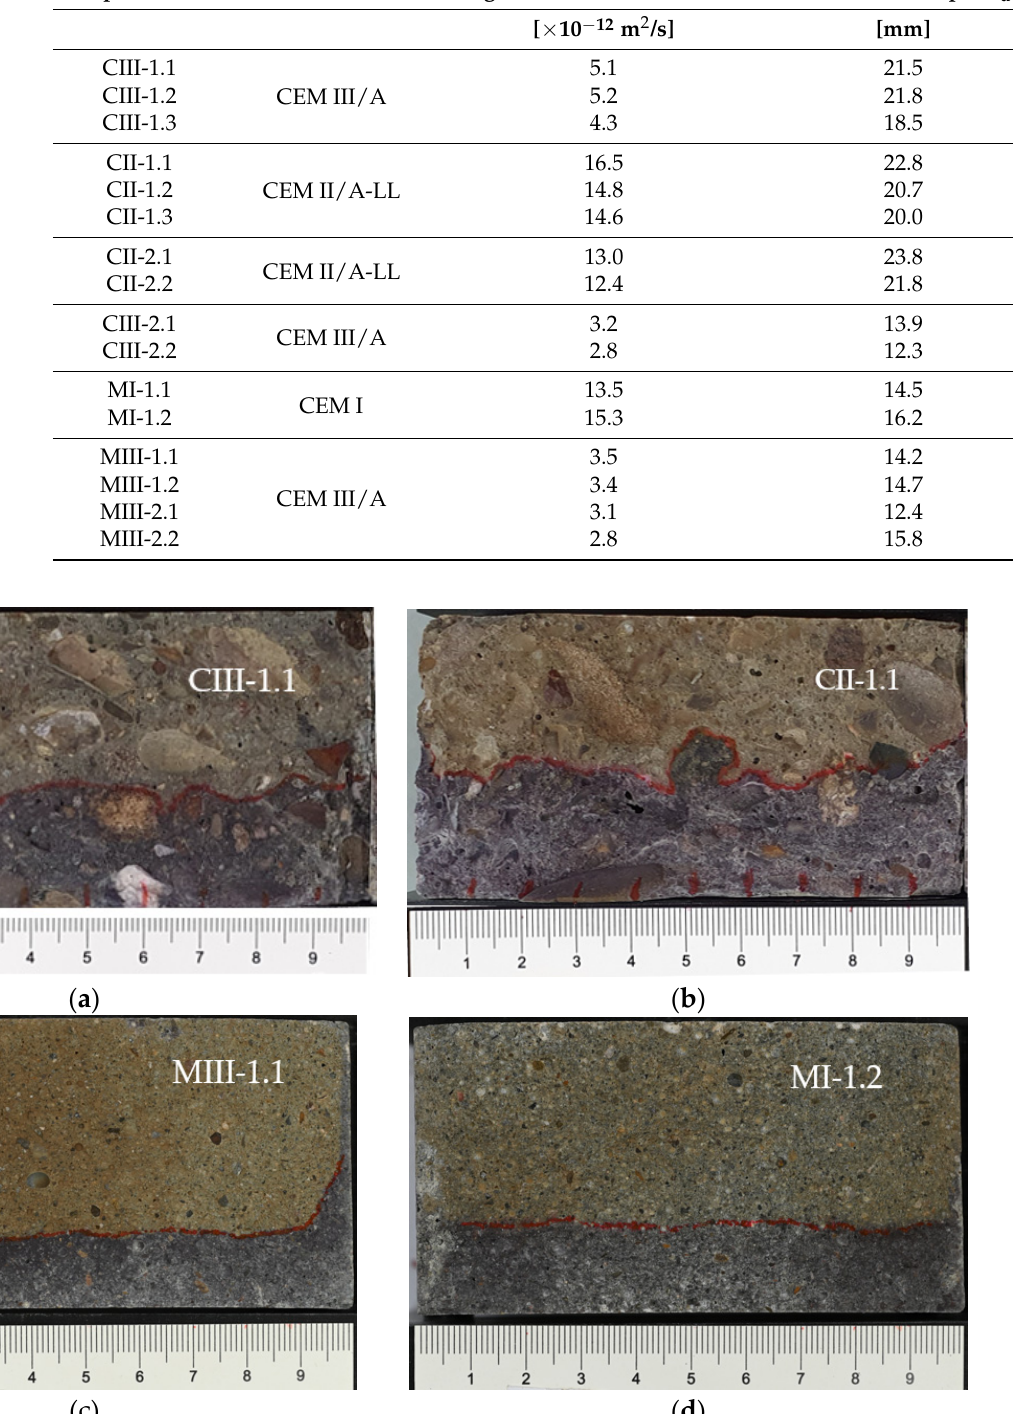
Table 3. Migration coefficients (D RCM ) and penetration depths (x d ) obtained in RCM test. Specimen Binder Migration Coefficient DRCM Penetration Depth x d